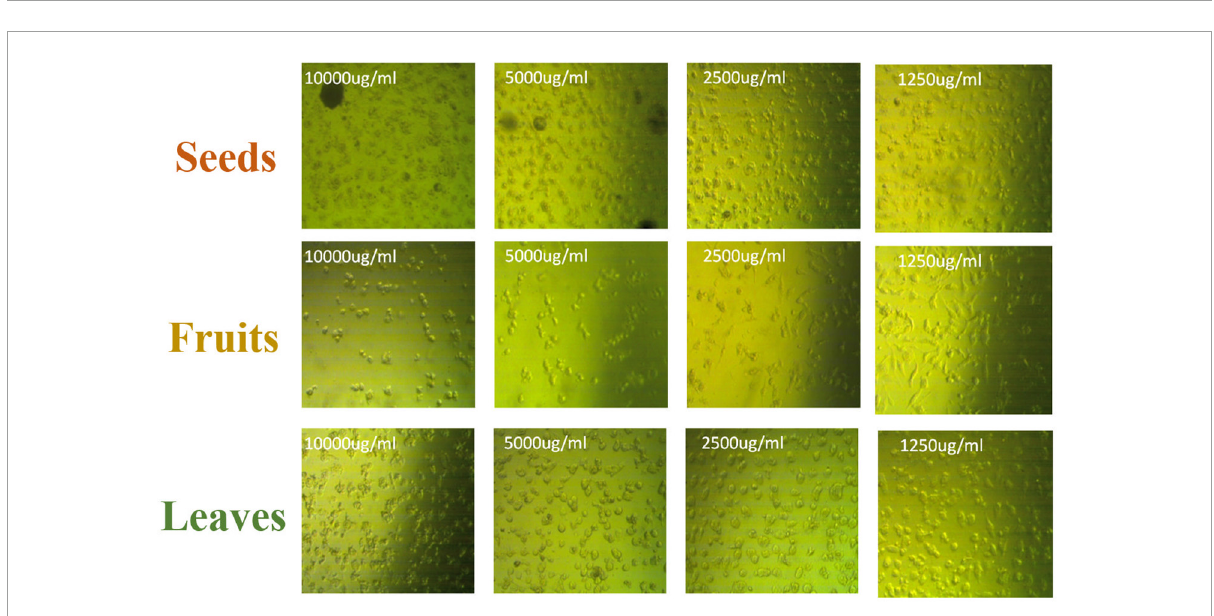
FIGURE7 Pc3 cytotoxic morphology after the treatment with leaf, seed, and fruit extracts separately in comparison with control.